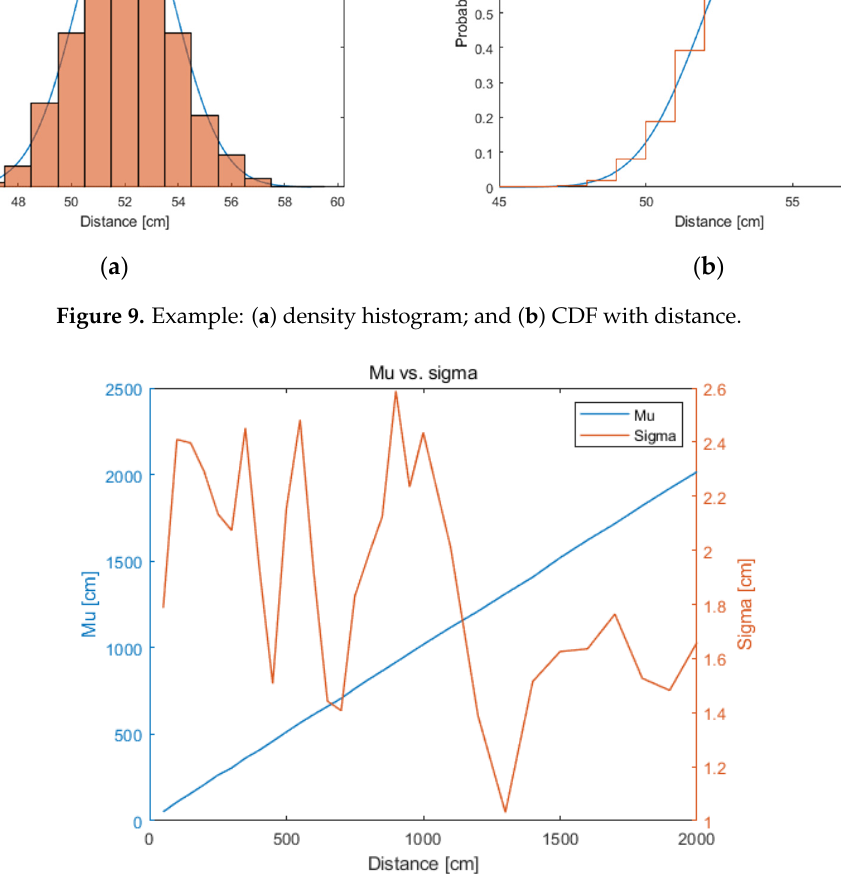
Figure 10. Normal distribution parameters.